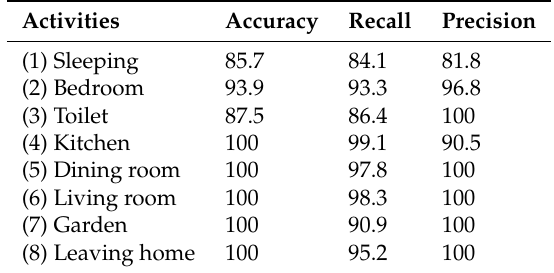
Table 2. Accuracy, recall, and precision for each activity obtained based on the proposed N-FFSM